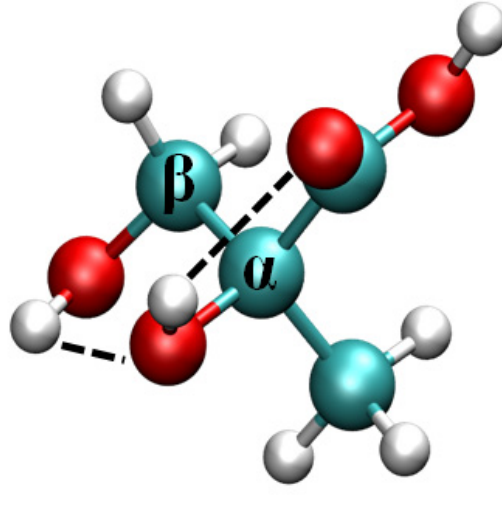
Figure 1. The most stable structure of MGA.